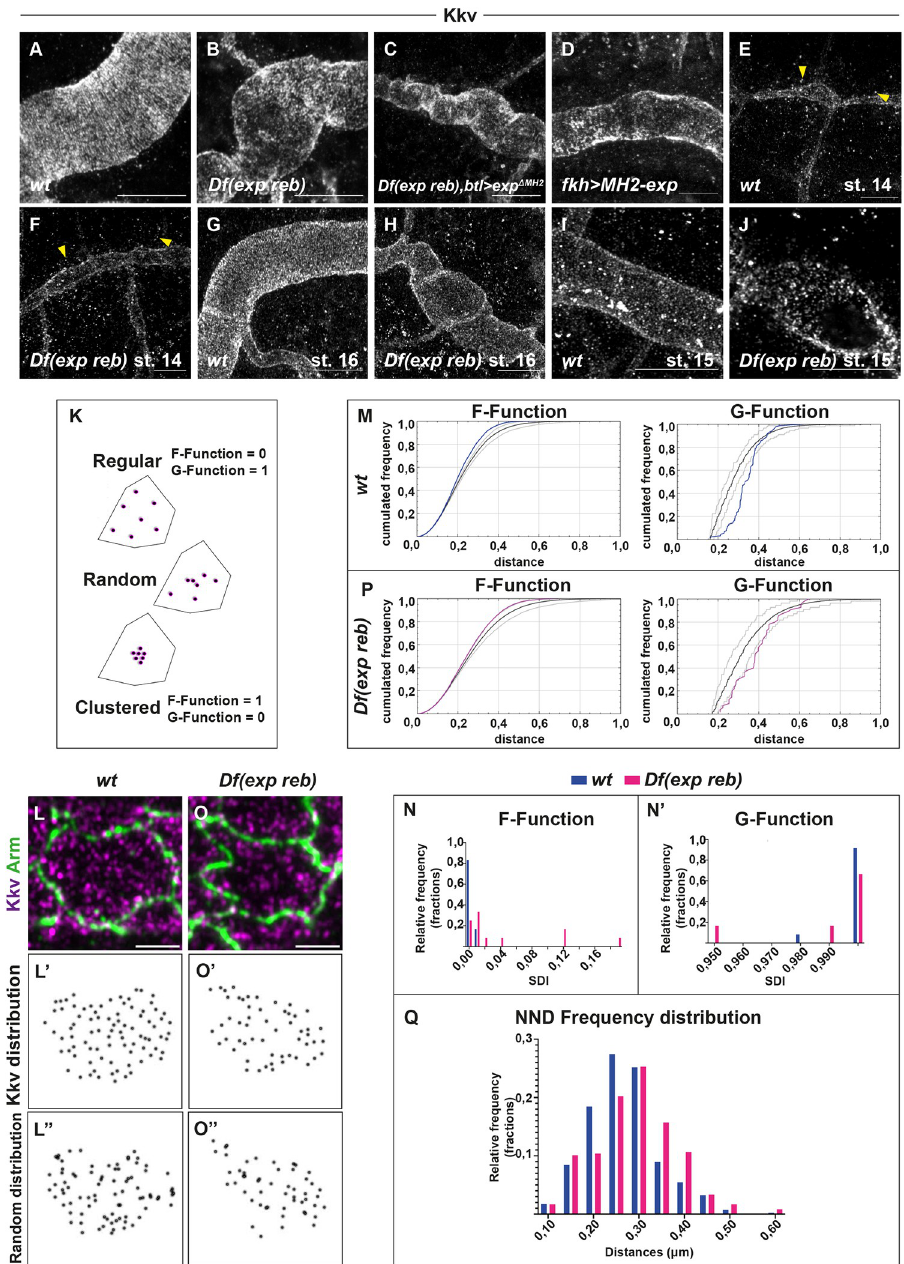
Fig 6. Analysis of Kkv apical distribution. All images are projections of confocal sections, of super-resolution microscopy. ( A , B ) Kkv localises apically in the trachea of wild-type embryos ( A ) and in absence of exp reb ( B ). ( C , D ) The localisation of Kkv is apical also in presence of exp Δ MH2 in trachea ( C ) and in presence of MH2-exp in salivary glands ( D ). ( E , F ) At stage 14, in wild-type embryos ( E ) and in embryos deficient for exp and reb ( F ), Kkv is present in the apical membrane and in many intracellular vesicles (yellow arrowheads). ( G ) At stage 16, in wild-type embryo, Kkv apical distribution follows the pattern of taenidial folds and intracellular vesicles are mostly absent. ( H ) At stage 16, in exp reb mutant embryos, Kkv is apical but shows altered distribution pattern. ( I , J ) At stage 15, in control embryos, Kkv pattern is apical and covers the whole membrane leaving minimal spatial gaps ( I ); instead, in exp reb mutant embryos, Kkv distribution changes to a less organised pattern at the apical membrane ( J ). ( K ) Three different types of spatial distribution within a selected area. The positions of the defined objects can be random and exhibit characteristics of attraction (clustered pattern) or repulsion (regular pattern). The F-Function tends to be larger ( � 1) for clustered patterns and smaller ( � 0) for regular. The G-Function tends to be smaller ( � 0) for clustered and larger ( � 1) for regular patterns. ( L ) Kkv punctae (magenta) on the apical cell area marked by Armadillo (green) in